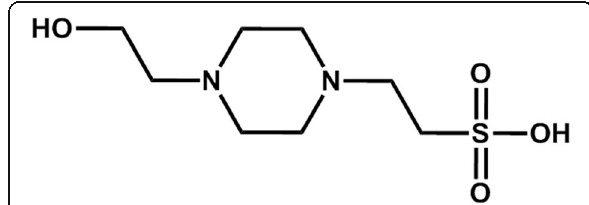
Fig. 1 Chemical structure of HEPES (4-(2-hydroxyethyl)-1- piperazineethanesulfonic